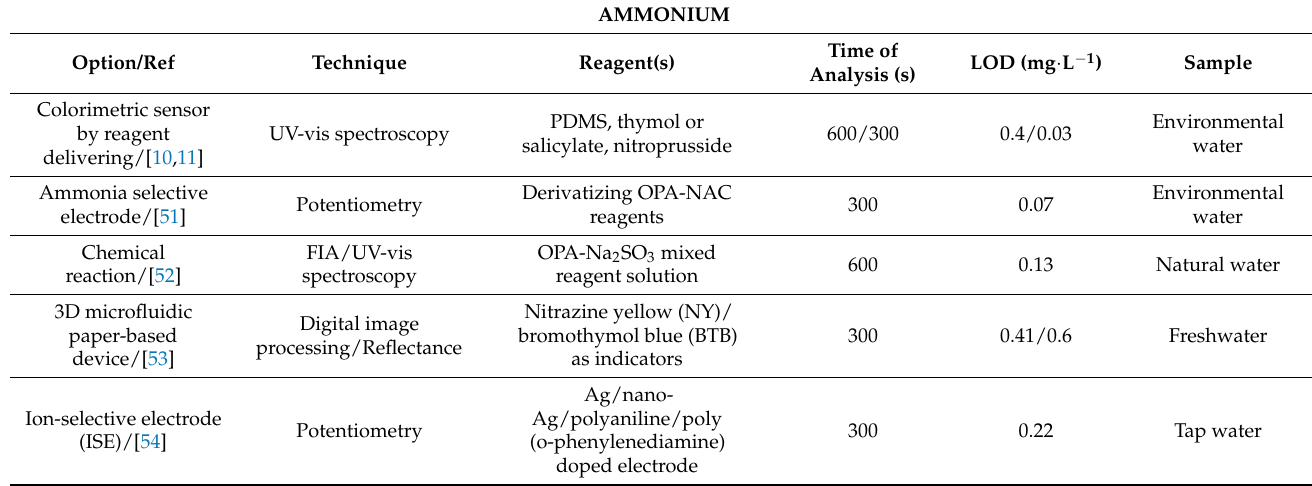
Table 7. Selected methodologies for ammonium and urea